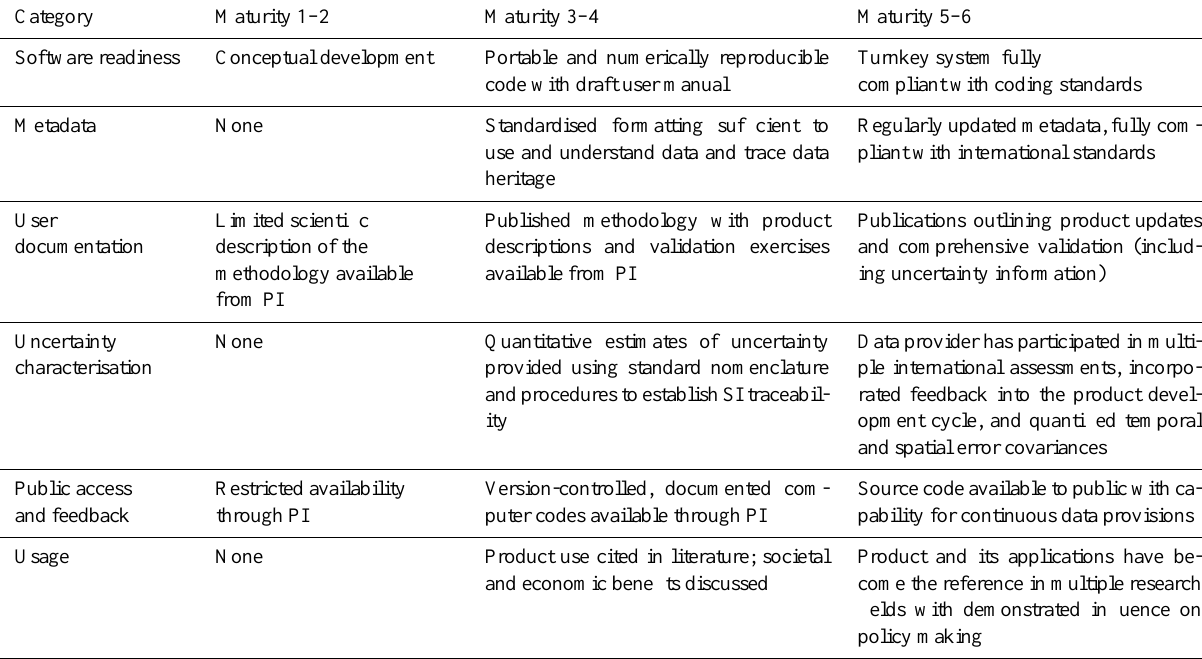
Table 4. Excerpts of the system maturity matrix defined by Work Package 2 (2013), available at http://www.coreclimax.eu/sites/coreclimax.